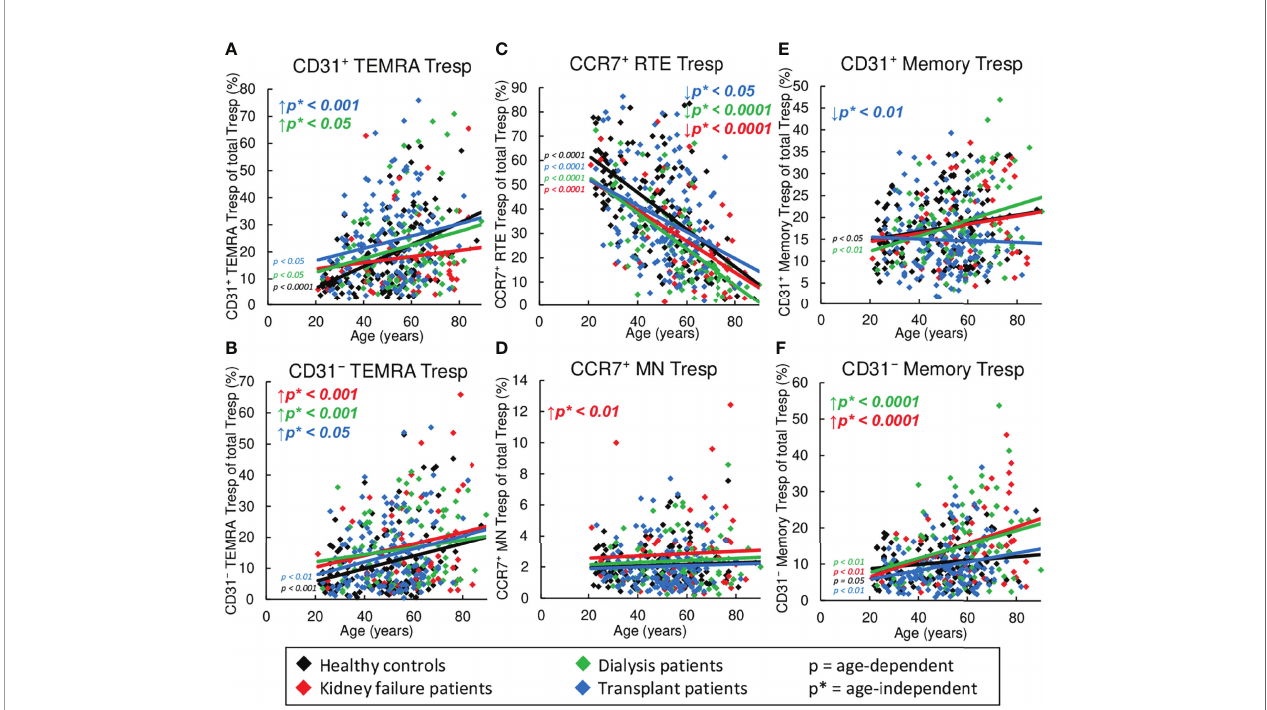
FIGURE 5 | Changes in the composition of CD8 + Tresps with differentially matured subsets in healthy controls (n=134), KF patients (n=57), dialysis patients (n=87), and kidney transplant patients (n=138). The fi gures present the percentages of CD31 + TEMRA (A) , CD31 - TEMRA (B) , CCR7 + RTE (C) , CCR7 + MN (D) , CD31 + memory (E) , and CD31 - memory Tresps (F) within total Tresps of healthy volunteers ( ♦ ), KF patients ( ♦ ), dialysis patients ( ♦ ), and kidney transplant patients ( ♦ ). Regression lines concerning changes in the percentages with age are shown for both healthy volunteers and all patient groups. Signi fi cant changes are marked by color-matched p-values. Age-independent signi fi cant differences between healthy volunteers and study groups are marked by an arrow ( ↑↓ ) and their color-matched